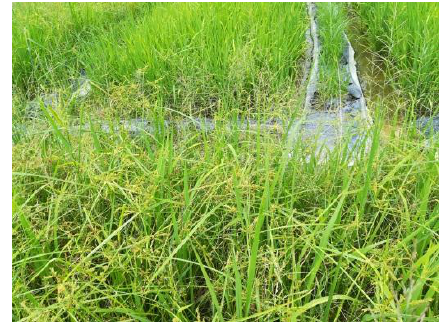
Figure 2. An overview of the weed patches in the field.